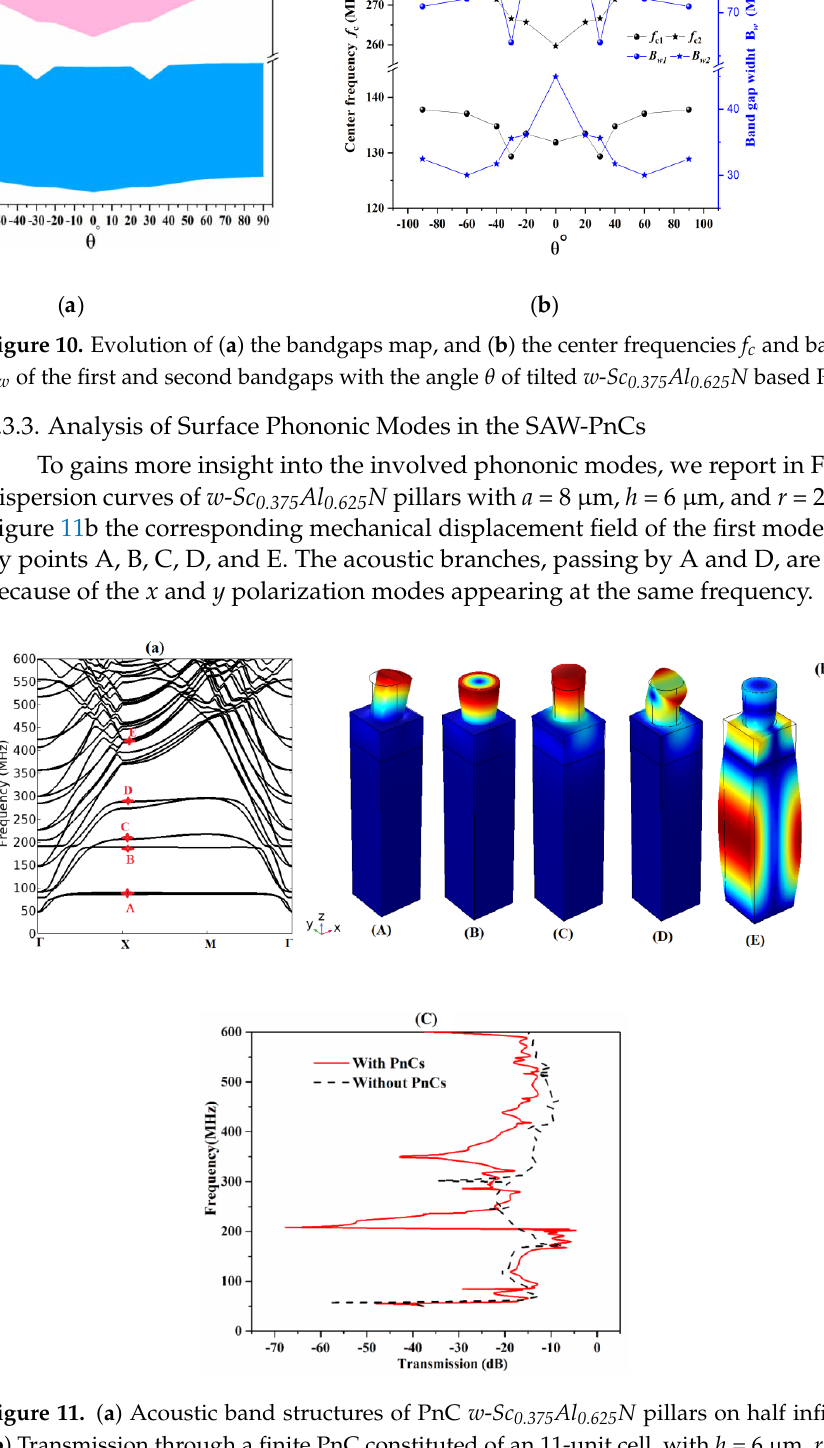
Figure 11. ( a ) Acoustic band structures of PnC w - Sc 0.375 Al 0.625 N pillars on half infinite substrate. ( b ) Transmission through a finite PnC constituted of an 11-unit cell, with h = 6 µ m, r = 2.6 µ m, and a = 8 µ m (red solid line) compared to the SAW through a non-structured surface (dashed lines). ( c ) Map of the mechanical displacement fields of modes (A, B, C, D, and